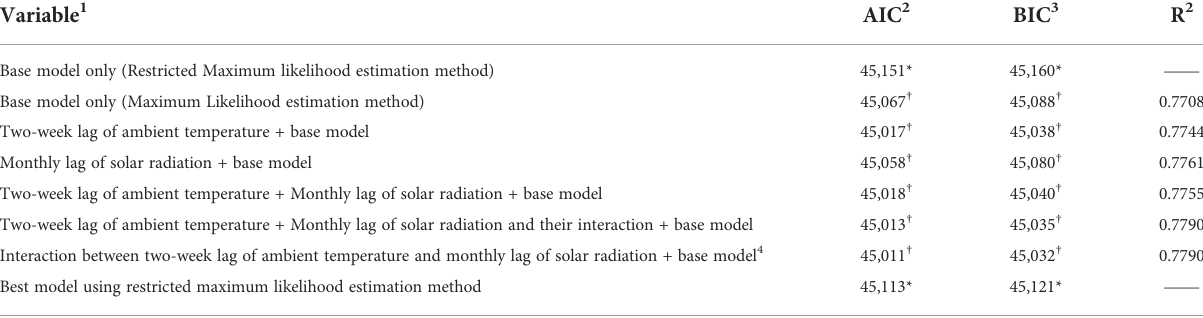
TABLE 10 AIC, BIC, and R 2 (coef fi cient of determination) values of various models examining solar radiation as a predictor variable for DMI in beef steers to summarize the model fi t in each stepwise process. Variable